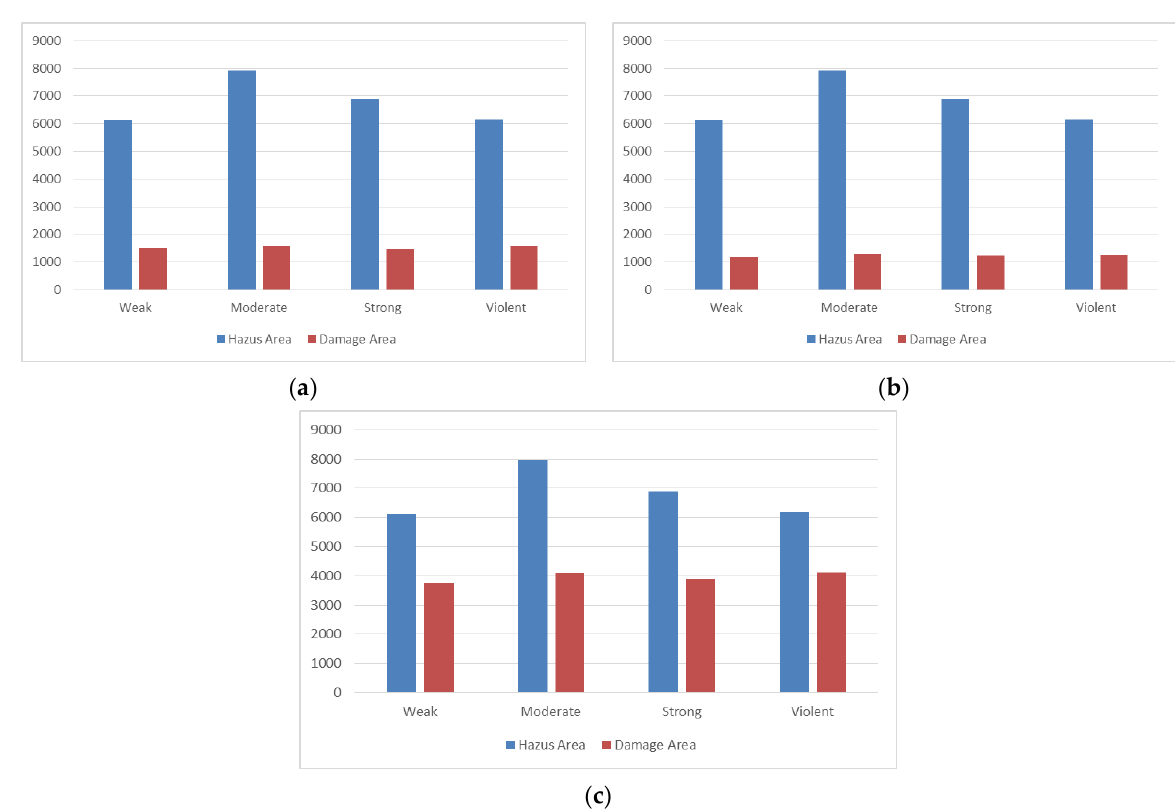
Figure 14. The area values (km 2 ) included by each class in our estimated damage map and FEMA HAZUS loss model map for the Naive Bayes ( a ), SVM ( b ), and deep learning ( c ) algorithms.